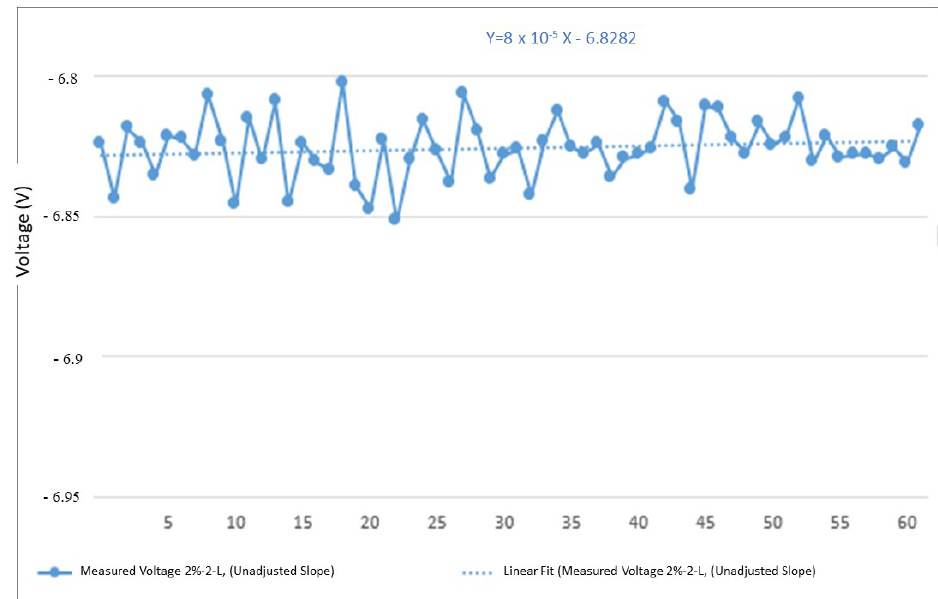
Figure 15. Static Voltage Measurements (2%, Column 2, Left Electrode Pair).